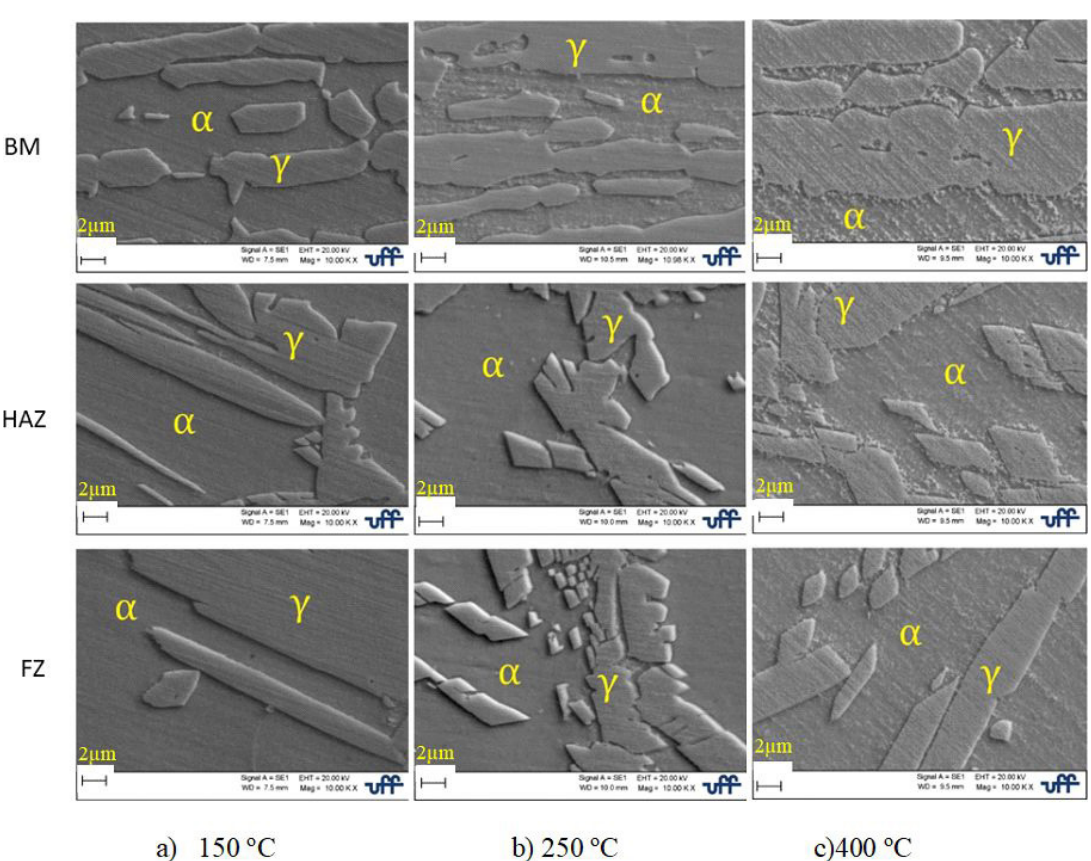
Figure 6. SEM micrographs of the BM, HAZ, and FZ regions (from top to bottom) of a stainless-steel tube welded with inter-pass temperatures: a) 150 °C, b) 250 °C, and c) 400 °C, respectively.